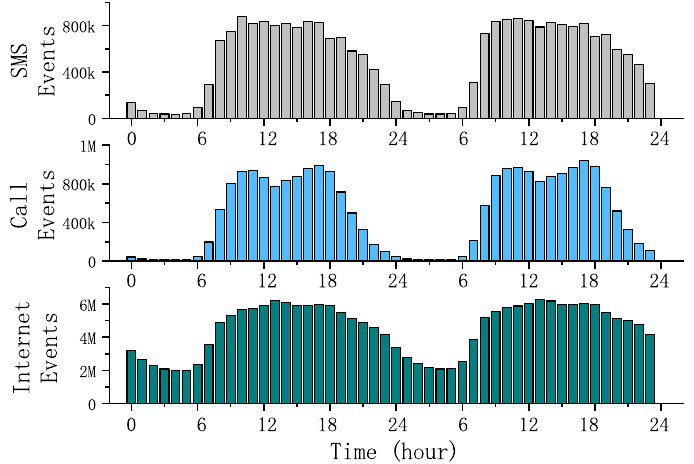
Figure 1. Hourly traffic change